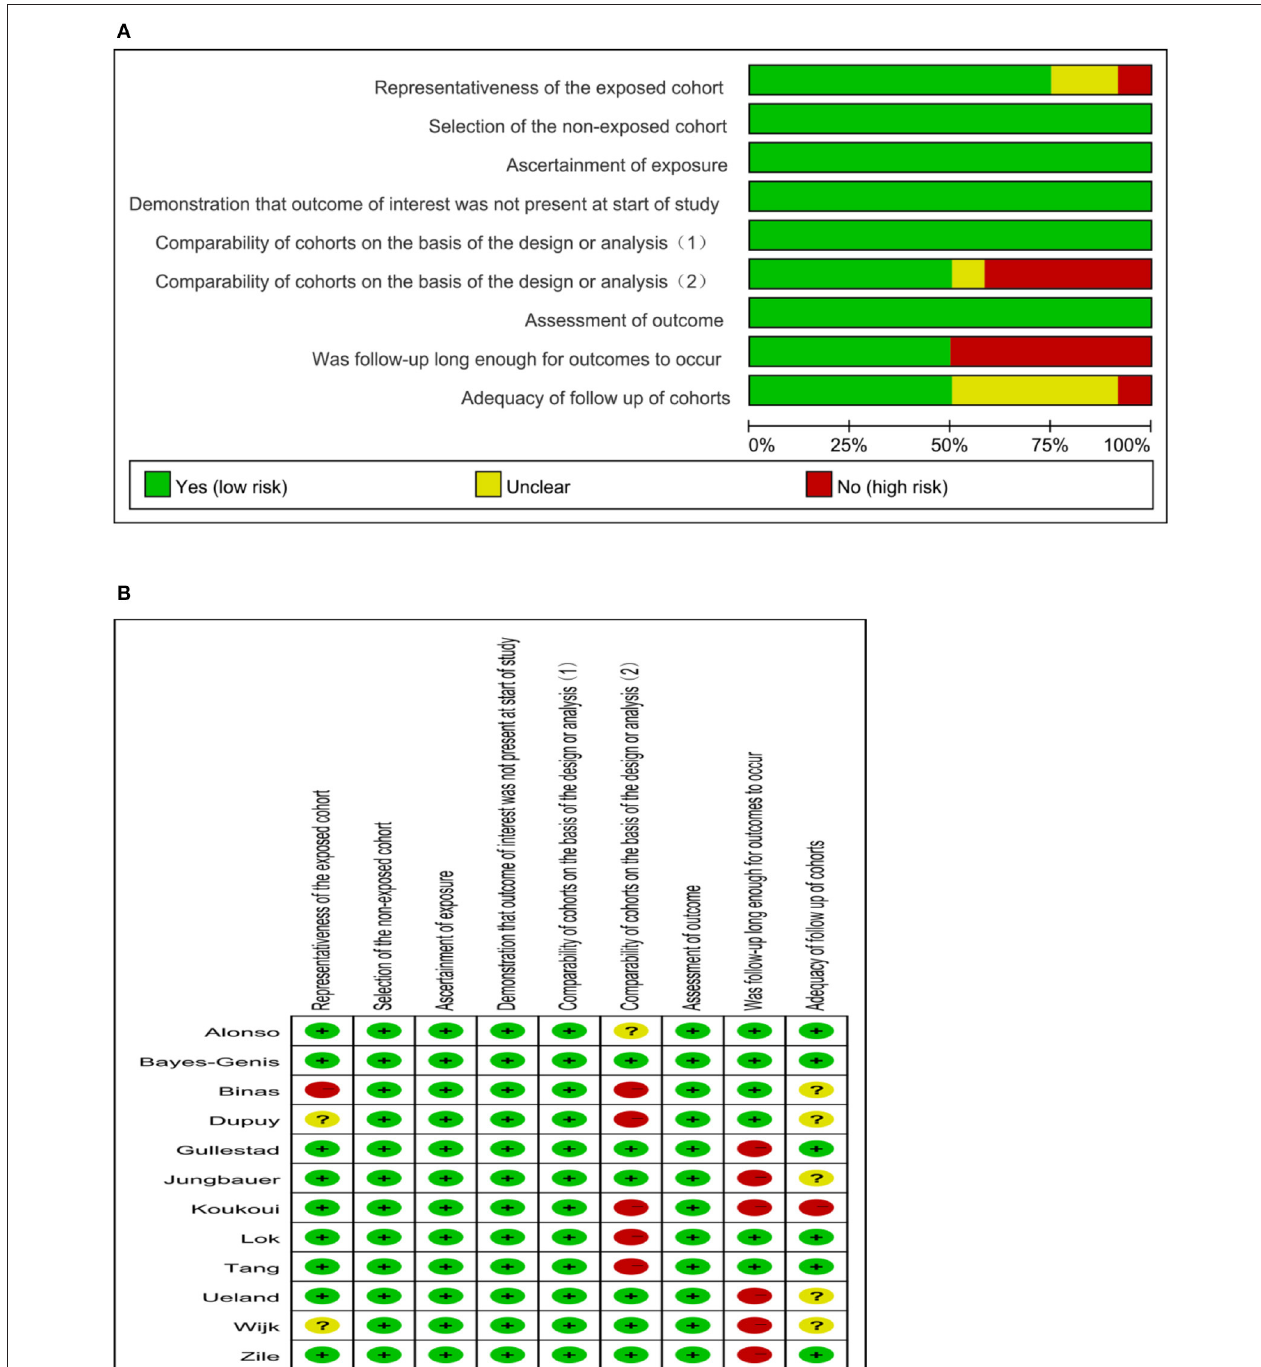
FIGURE 2 | Quality evaluation of the eligible studies. (A) Review authors’ judgments presented as percentages across included studies; (B) Review authors’ judgements about each domain for each included